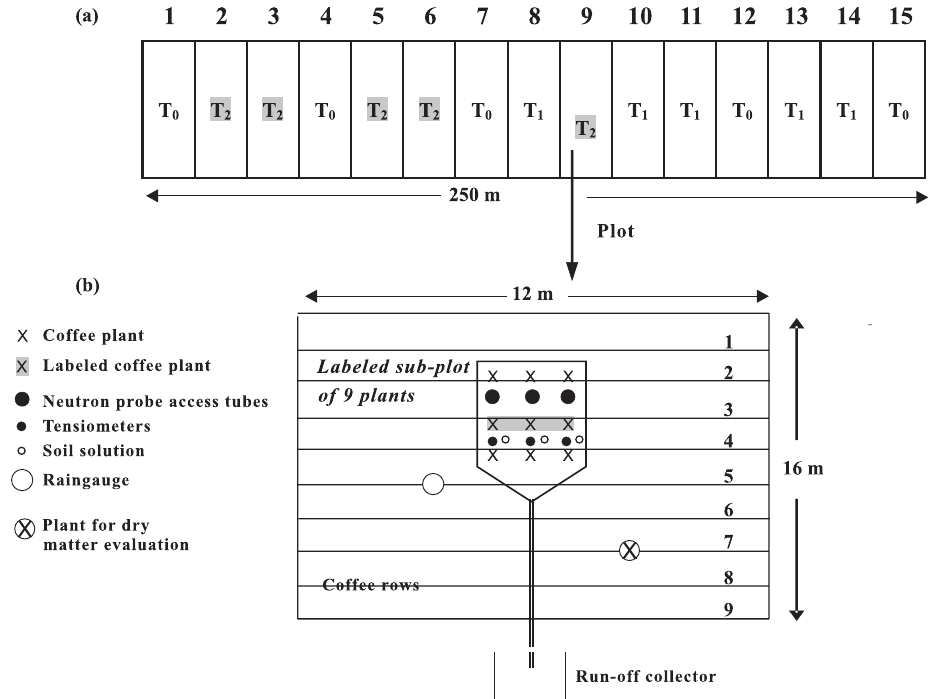
Figure 1. Schematic field layout: (a) Distribution of treatments T plantation; (b) Details of a T sub-plot of nine plants, with the central row of three 15 N labeled plants, and the location of